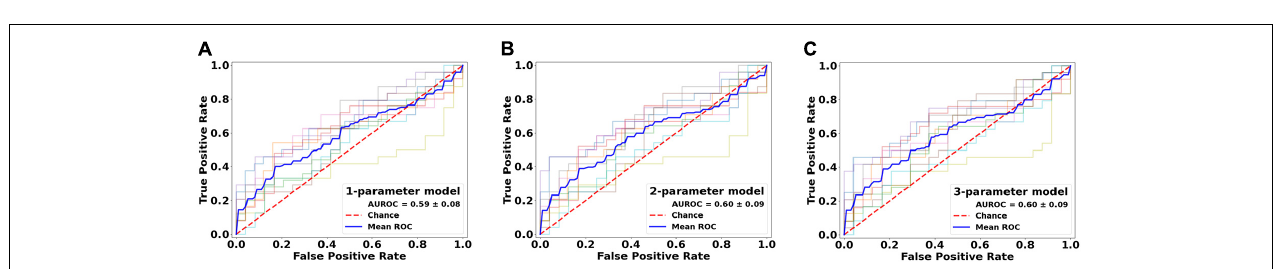
FIGURE 8 | Performance comparison of the classification models in the lesion core versus shell analysis. Shown are the ROC curves for models constructed from the top three ranked diffusion features: (A) mean diffusivity (MD) alone, (B) MD + radial diffusivity (RD), and (C) MD + RD + fractional anisotropy. ROC, receiver operating characteristics; AUROC, area under the ROC